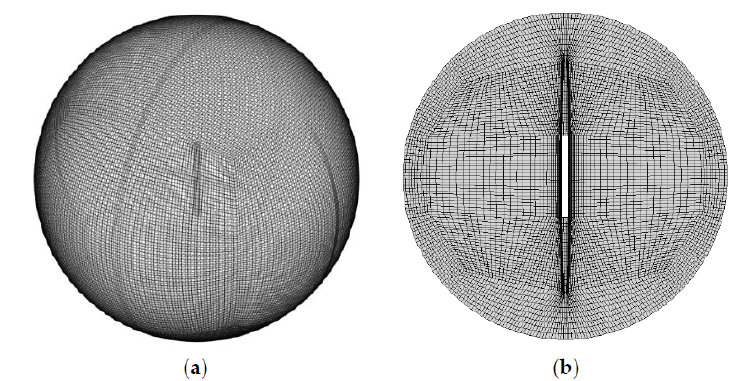
Figure 2. Structural mesh in the spherical cavity (( a ): 3D sphere, ( b ): Section z = 0).